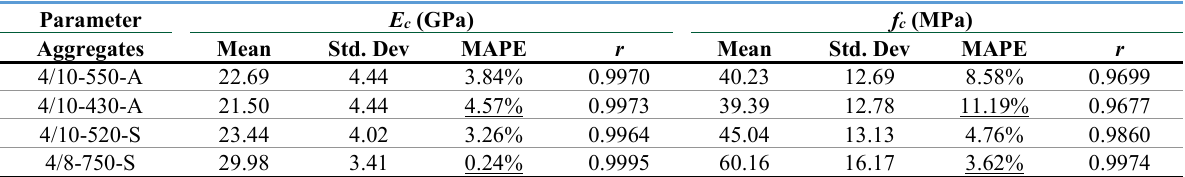
Table 4 N umerical results of the mechanical properties (Young’s modulus, E c ; and compressive strength, f c ) for each aggregate type; including MAPE and Pearson correlation coefficient (r) statistical parameters.